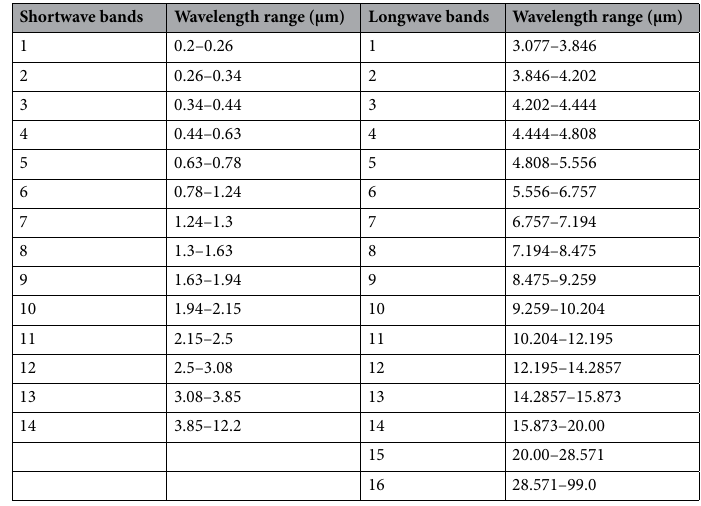
Table 2. The shortwave and longwave bands of the radiative transfer module of CESM/CAM5